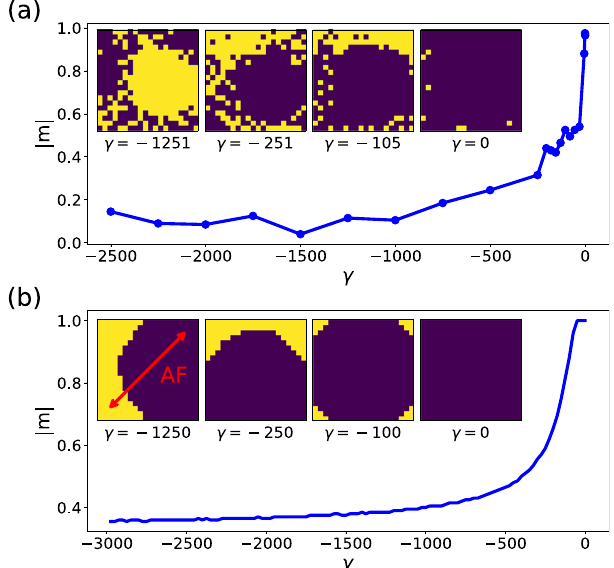
Fig. 5 Zero temperature magnetic phases of the nonlinear optical Ising machine with a negative four-body coef fi cient γ < 0. a Experimentally measured and ( b ) numerically obtained magnetization as a function of γ . The error bars in ( a ) are close to the size of the dots. The magnetization saturates to a nonzero value for large ∣ γ ∣ . The inset fi gures are the spin con fi gurations for some selected γ values. The spins located at the opposite corners of the SLM are antiparallel with each other, giving rise to an anti- ferromagnetic (AF) order shown by red